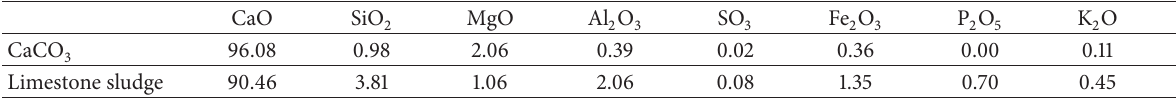
Table 1: Chemical composition of CaCO 3 and LSS (%).